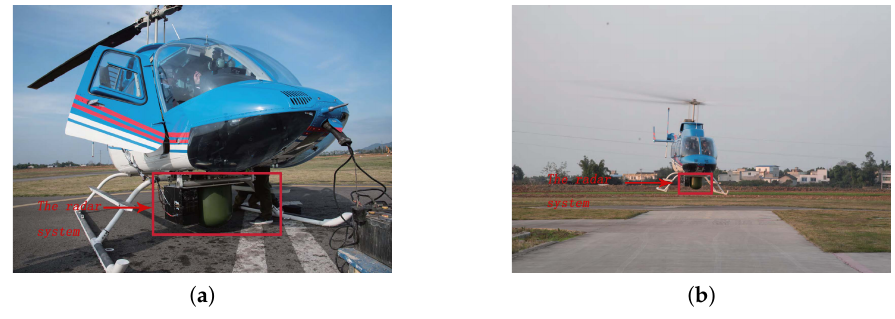
Figure 7. The Ka bandwidth radar system and helicopter platform. ( a ) The Ka bandwidth radar system. ( b ) The helicopter